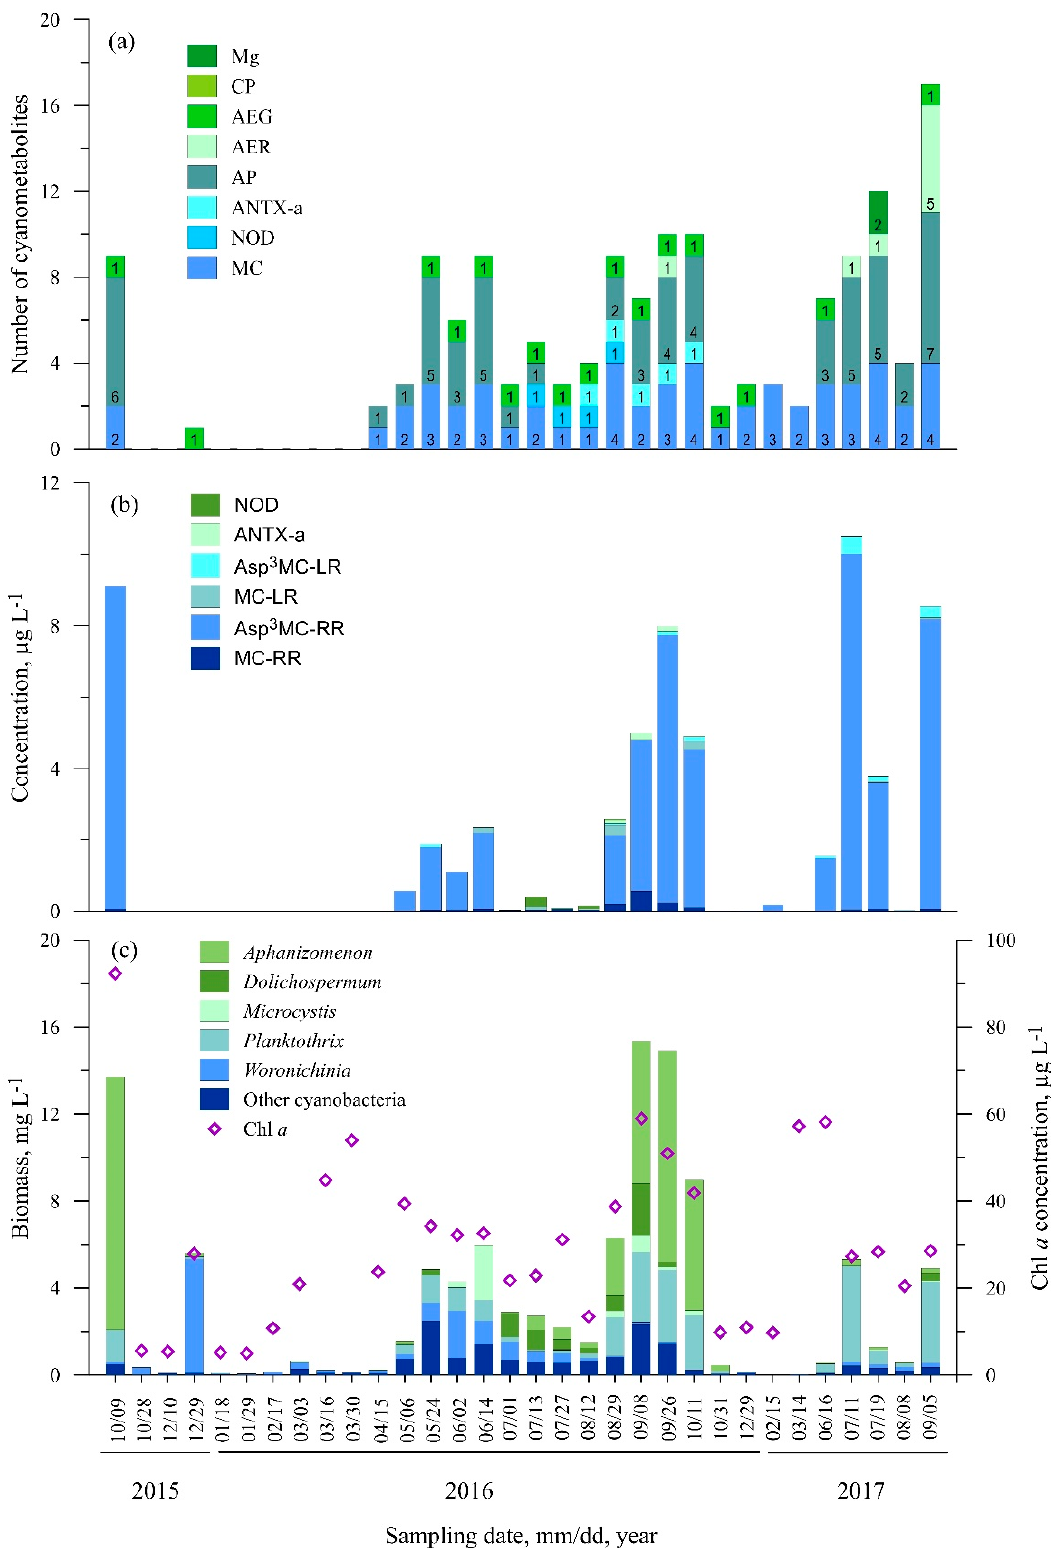
Figure 7. Seasonal changes in the number of cyanometabolites ( a ), concentration of microcystin and anatoxin variants ( b ), cyanobacteria biomass and Chl a concentration ( c ) at St. 5.